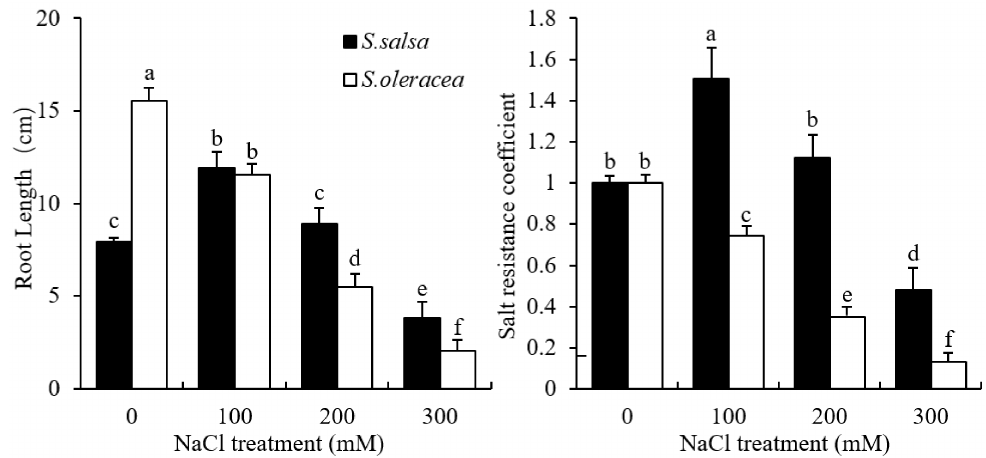
Figure 1. Final root growth and salt resistance coefficient of S. salsa and S. oleracea in 0, 100, 200, and 300 mM NaCl treatments. Data are mean + S.D. ( n = 5). Salt resistance coefficient was calculated as: root length of NaCl treatments/root length of 0 mM NaCl. Different letters indicate significant differences ( p <